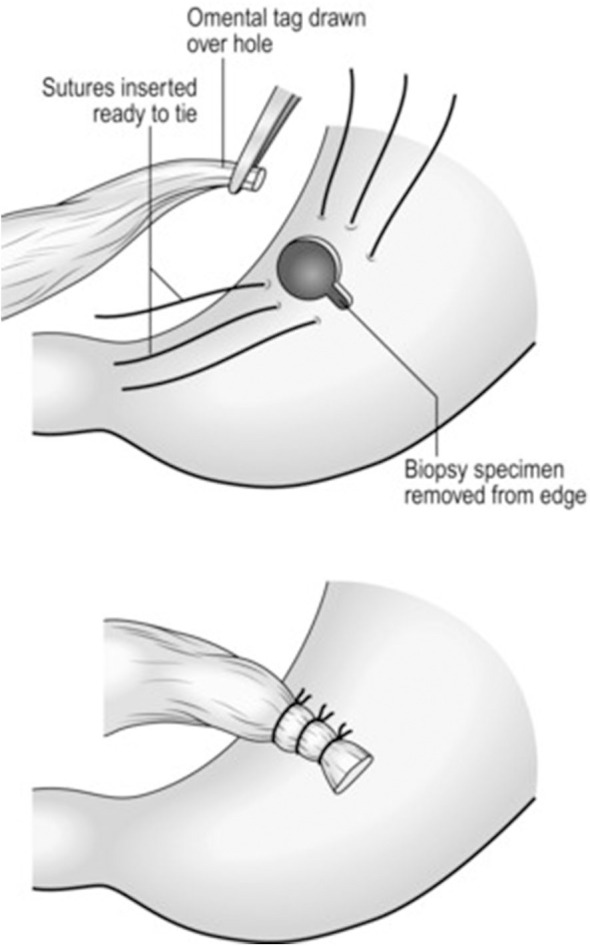
Schematic diagram of pedicled omental flap repair of gastric perforation.